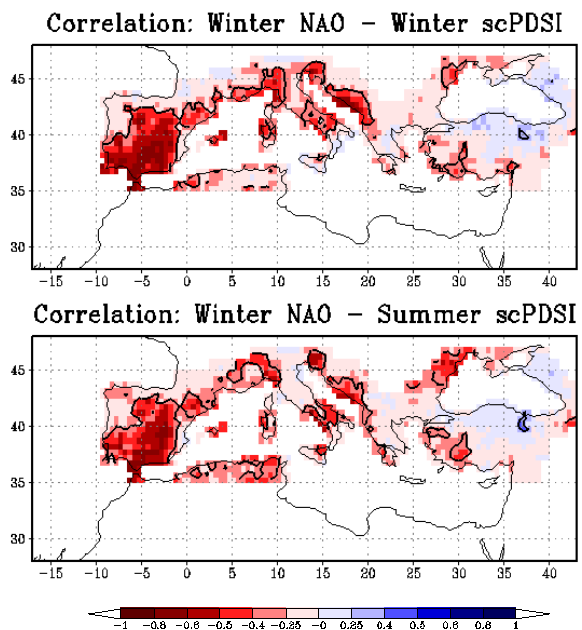
Fig. 11. As in Fig. 10 but for the SCAND pattern.